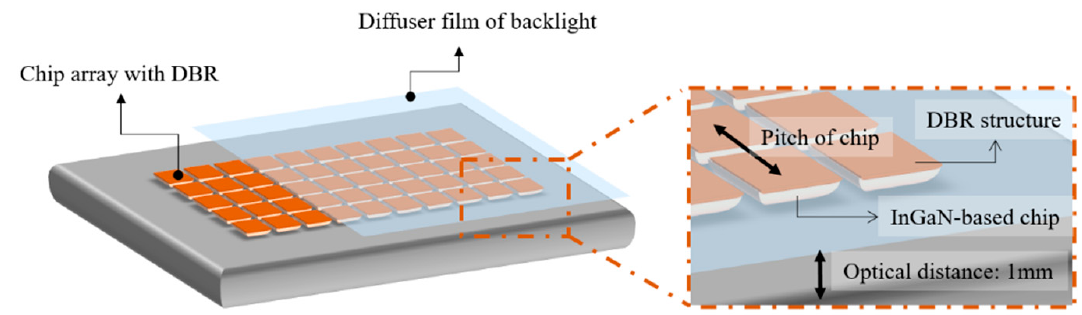
Figure 1. Mini light-emitting diode backlight with distributed Bragg reflector (DBR). The indium GaN (InGaN)-based chip array used in the model had an emission peak wavelength of 445 nm. The InGaN-based chip array was bonded to the opaque substrate, array (Figure 1). The optical detector, with dimensions of 30 mm × 30 mm, was placed in the parameters for the mini-LED backlight design with the